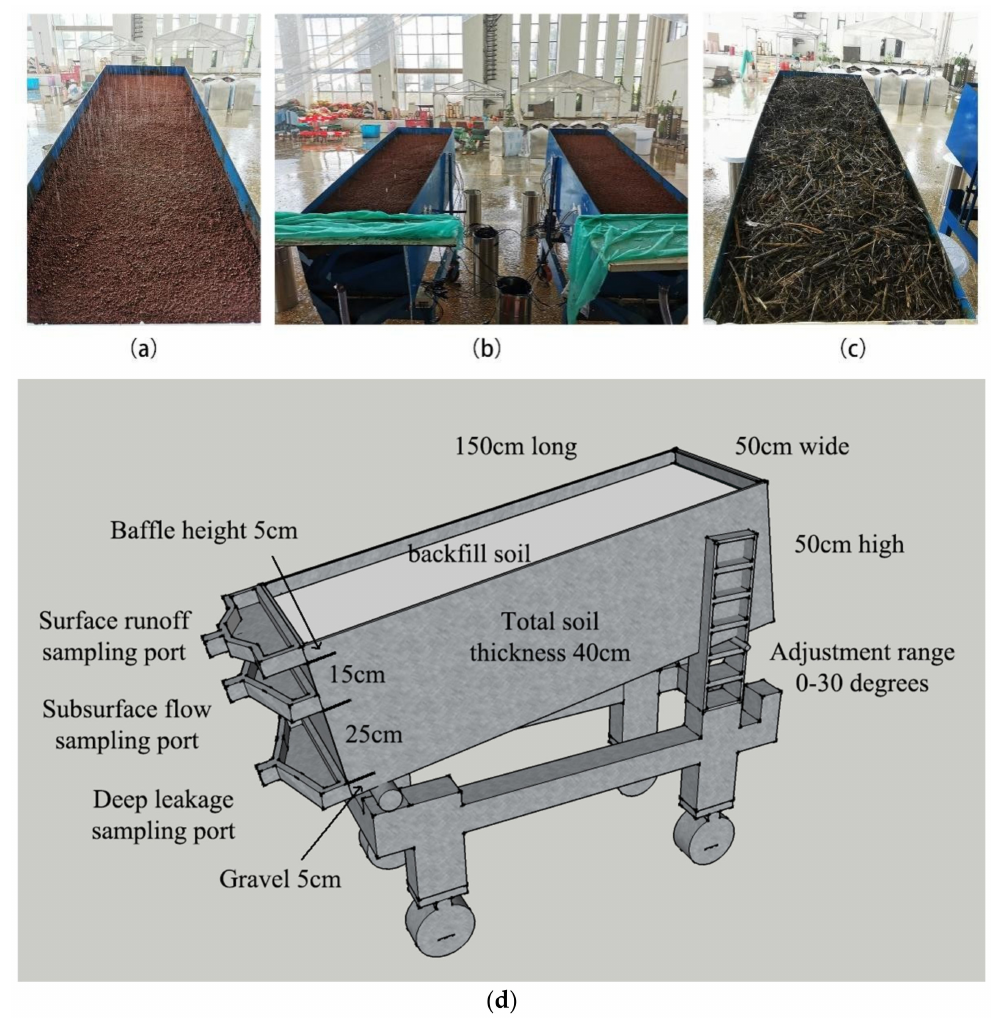
Figure 2. Experimental demonstration and soil tank schematic. ( a ) Uncovered soil tank. ( b ) Soil tanks during rainfall experiment. ( c ) Straw–covered soil tank. ( d ) Schematic diagram of steel soil